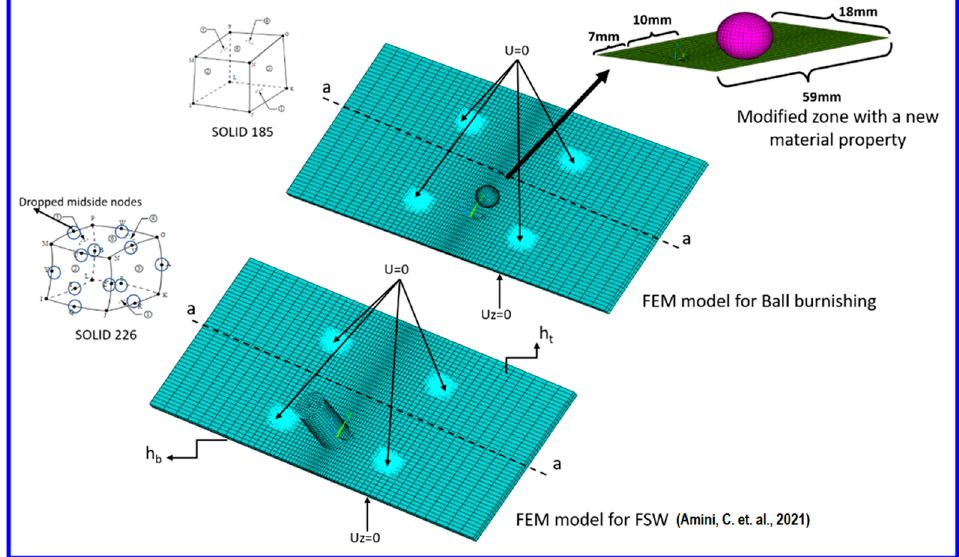
Figure 5. Display of FEM model for integrated numerical model between FSW and BB, adapted with permission from Ref. [15]. 2021, Springer Nature BV.